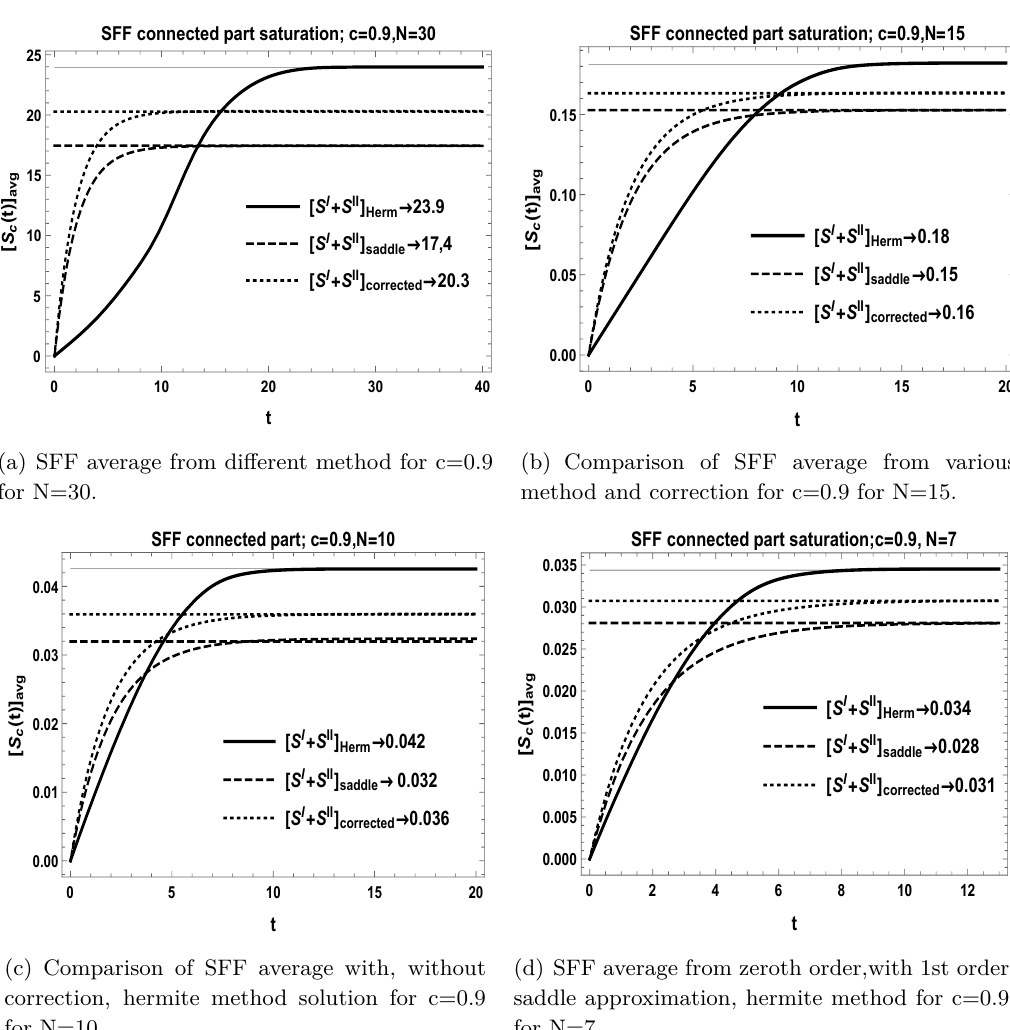
Figure 10 . SFF average has shift in saturation values. Here different solution from Hermite method, zeroth order saddle method and 1st order corrected saddle approximation is